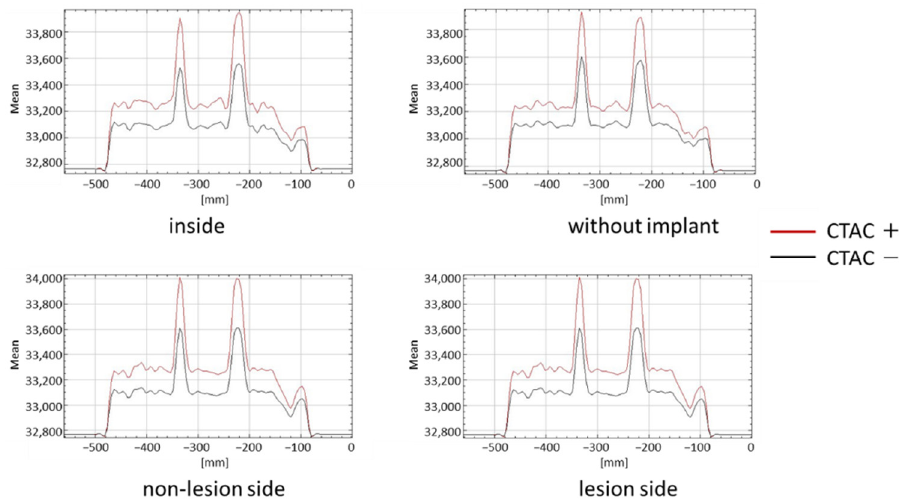
Figure 5. Quantification of lesions according to implant type and installation position with and without CTAC.